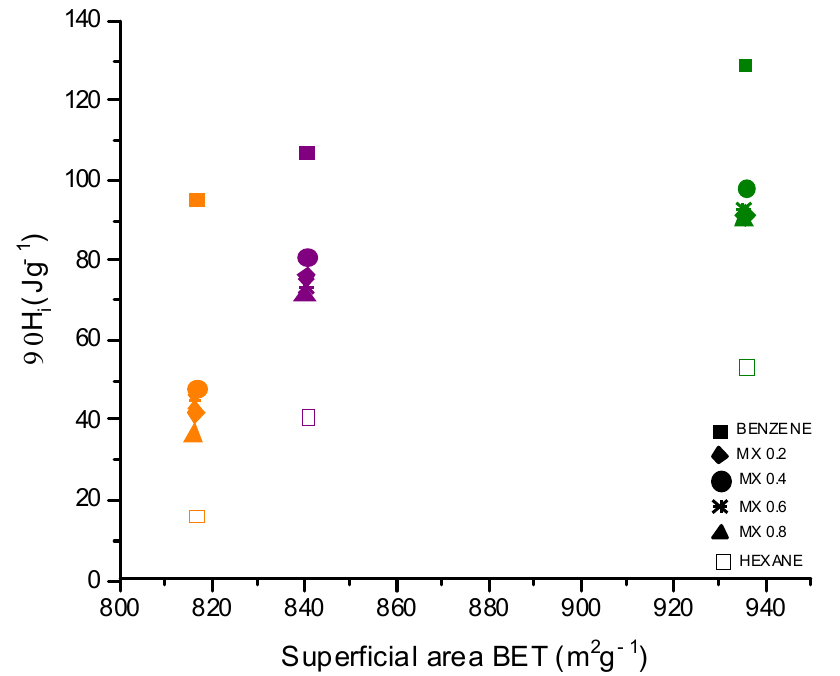
Figure 9. Enthalpies of immersion of solids in binary mixtures as a function of surface area BET. Finally, a relationship is established between the enthalpy of immersion of the acti- vated carbons in the two apolar solvents, benzene and hexane, the intermediate